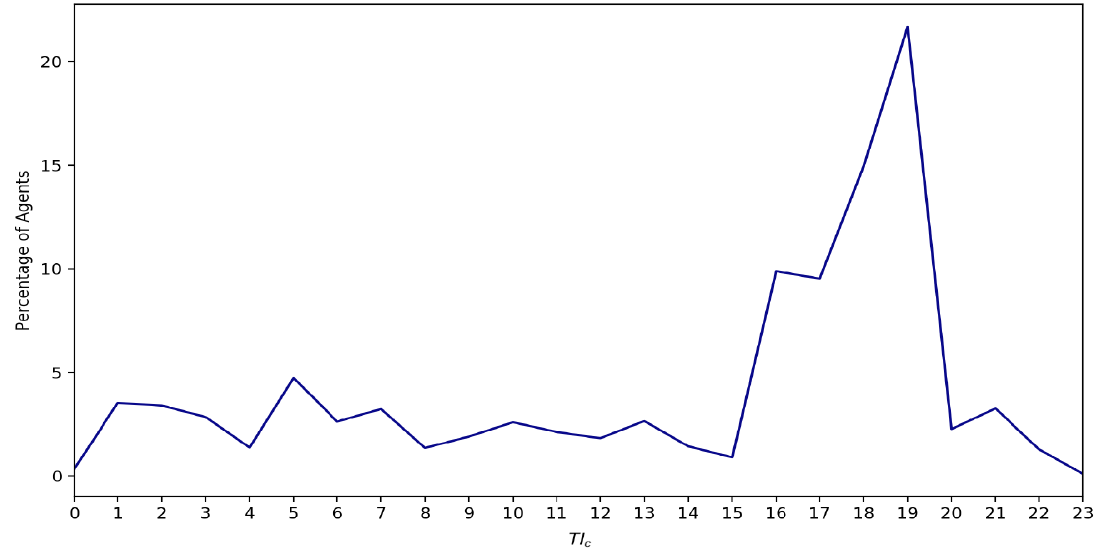
Figure 3. Consumer agents are assigned a value for TI c using the distribution of values shown